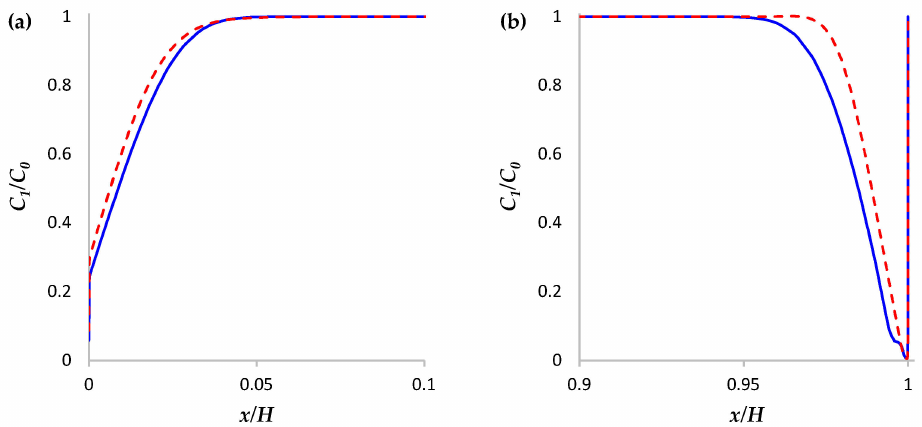
Figure 5. Concentration profiles of cations in the section y = 0.85 L calculated without a spacer (solid line) and with a spacer (dashed line) at the time point t = 170 s ( a , b ) regions near the surfaces of the anion- and cation-exchange membranes,